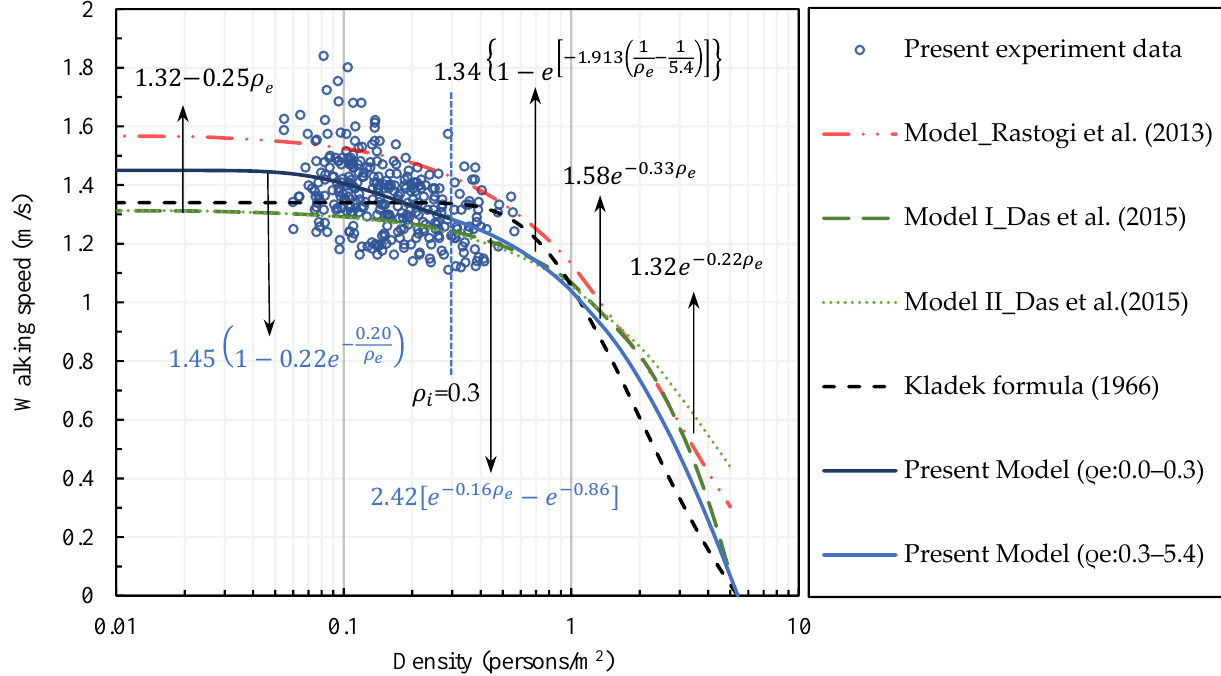
Figure 11. Speed – density relationship and modeling function [27,29,38,50]. Figure 11. Speed–density relationship and modeling function [27,29,38,50]. Rastogi et al.’s (2013) model [27] revisited the Underwood model (1961) [37]